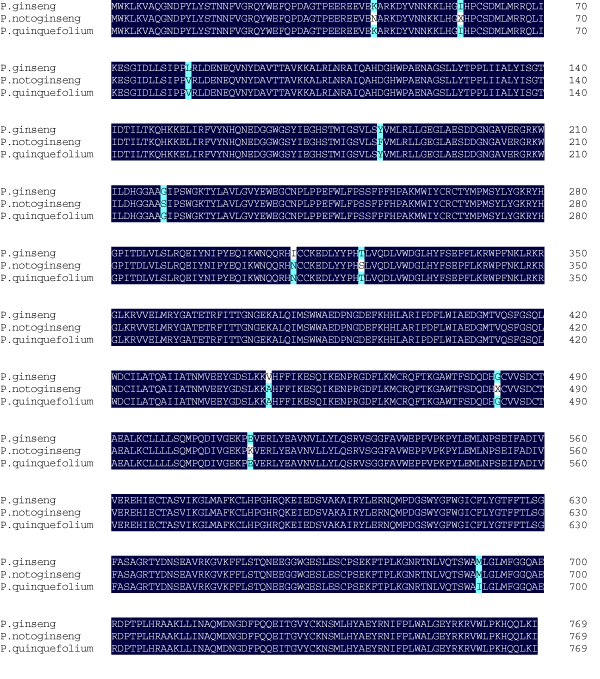
Alignment of DS amino acid residues from P. ginseng, P. quinquefolium, and P. notoginseng. P. ginseng DS and P. quinquefolius DS showing 99.5% identity, P. quinquefolius DS and P. notoginseng DS showing 99.0% identity, P. ginseng DS and P. notoginseng DS showing 98.7% identity.